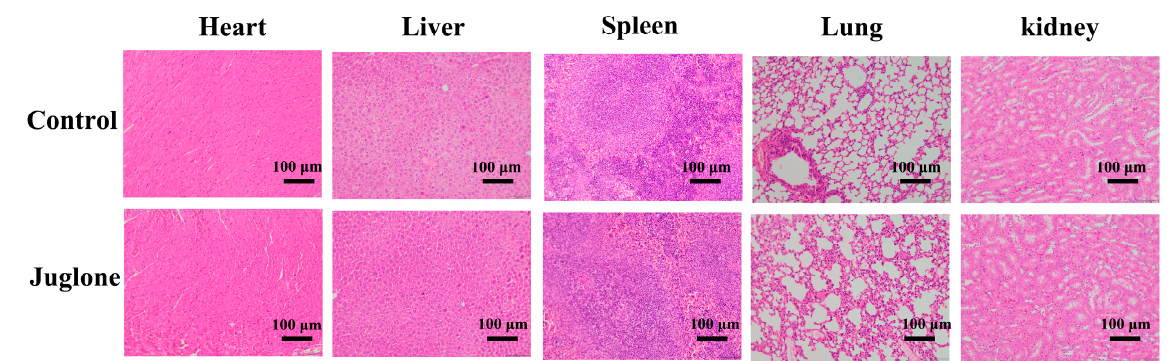
Figure 10. The effect of juglone on the levels of inflammatory factors in mice with S. aureus -infected wounds. The expression level of TNF- α ( A ), IL-6 ( B ) and IL-1 β ( C ) in the serum of mice after three days of local treatment with juglone. The expression level of TNF- α ( D ), IL-1 β ( E ) and IL-6 ( F ) in the wound tissue of mice after three days of local treatment with juglone. When p < 0.01, it is represented by **, when p < 0.05, it is represented by *.